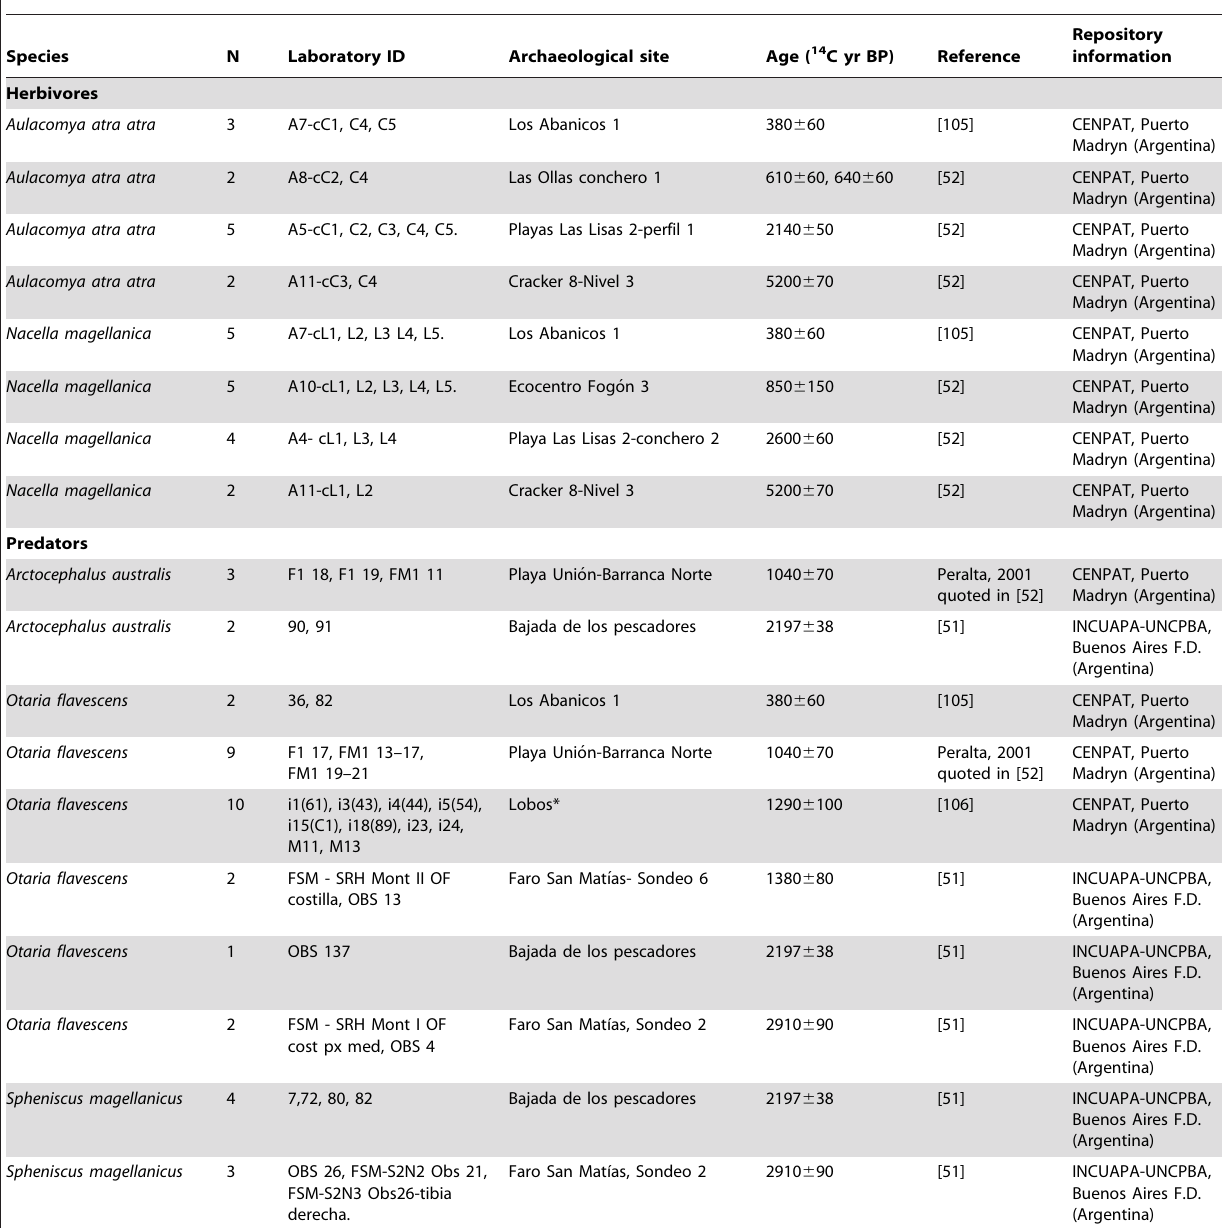
Table 2. Archaeological samples from northern-central